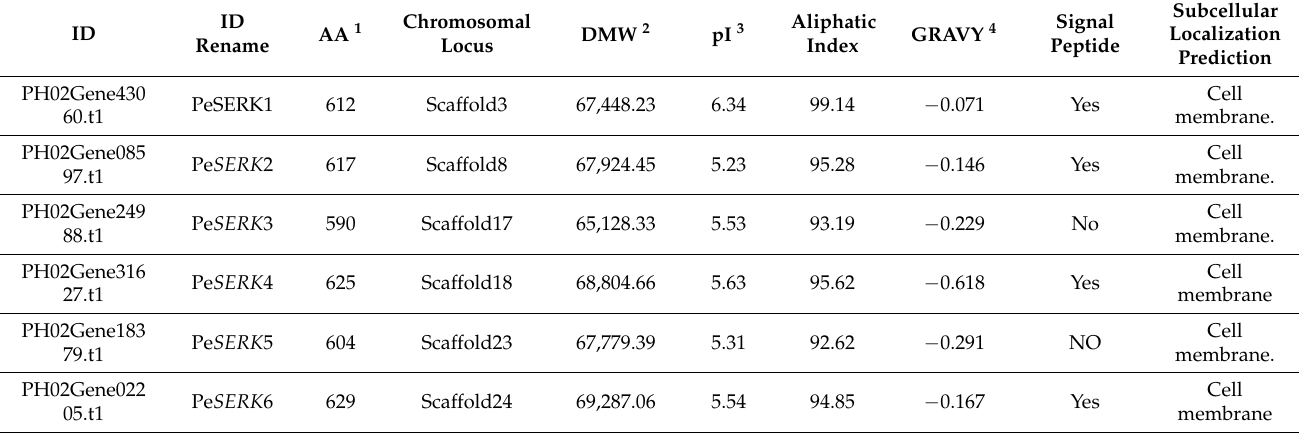
Table 2. Characteristics of PeSERKs in moso